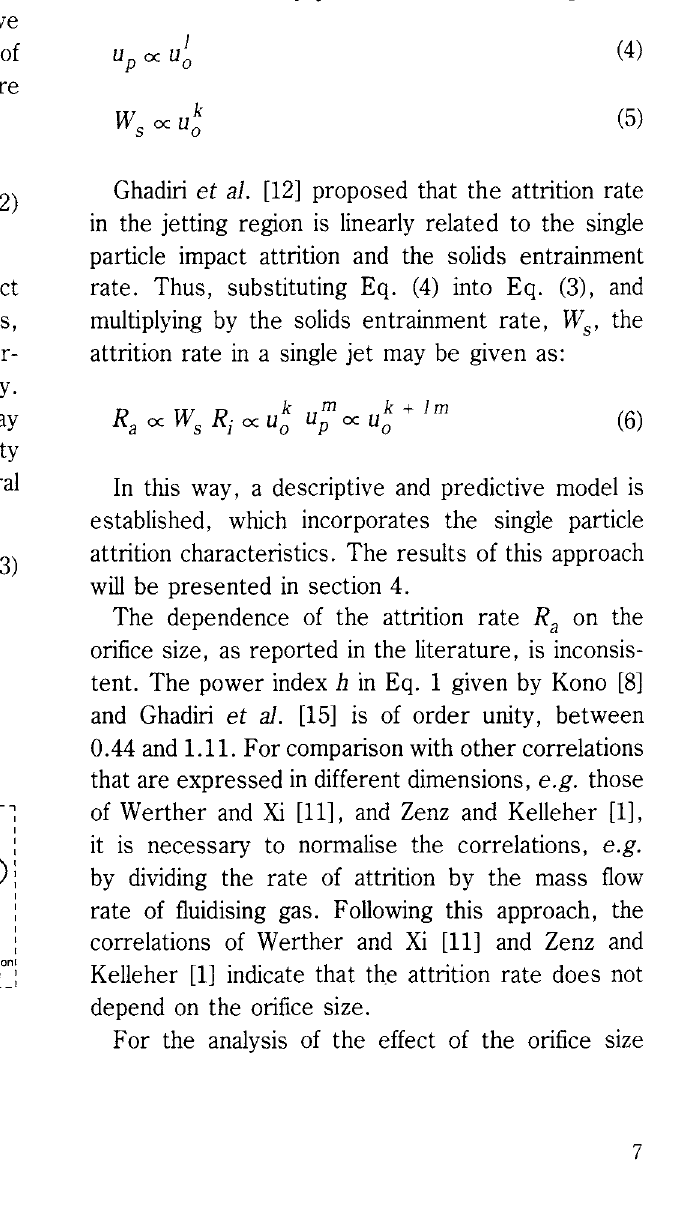
Fig. 1 Schematic representation of the modelling